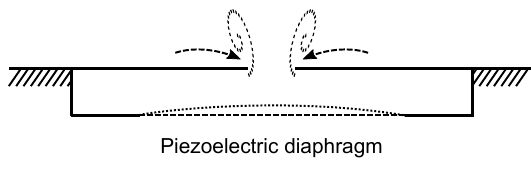
Figure 3. Schematic view of a synthetic jet with piezoelectric diaphragm.